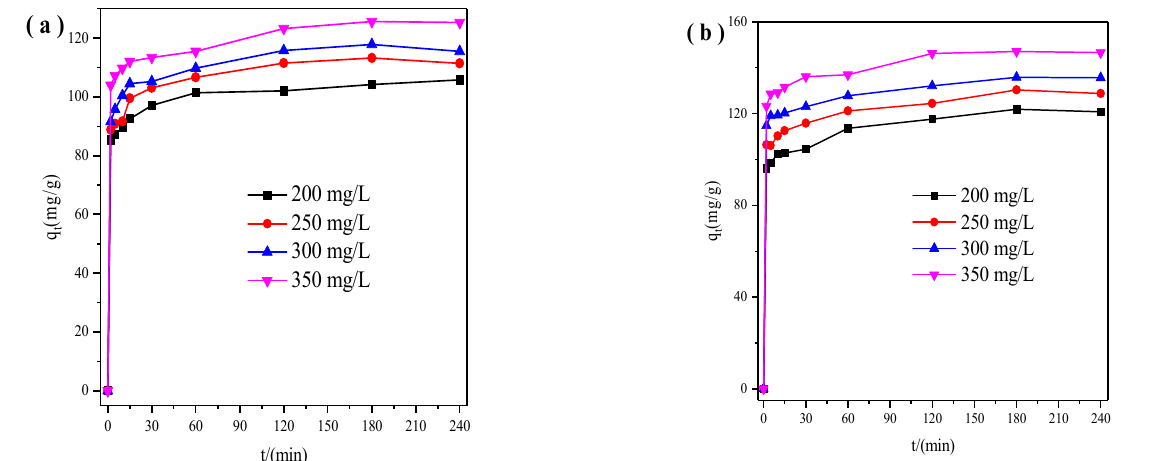
Figure 1. Relationship between time and adsorption capacity of X zeolite for Cu 2+ ( a ) and Zn 2+ ( b ) with different concen- trations.